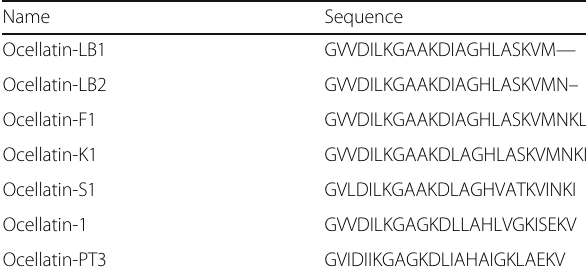
Table 2 Amino acid sequences of antimicrobial